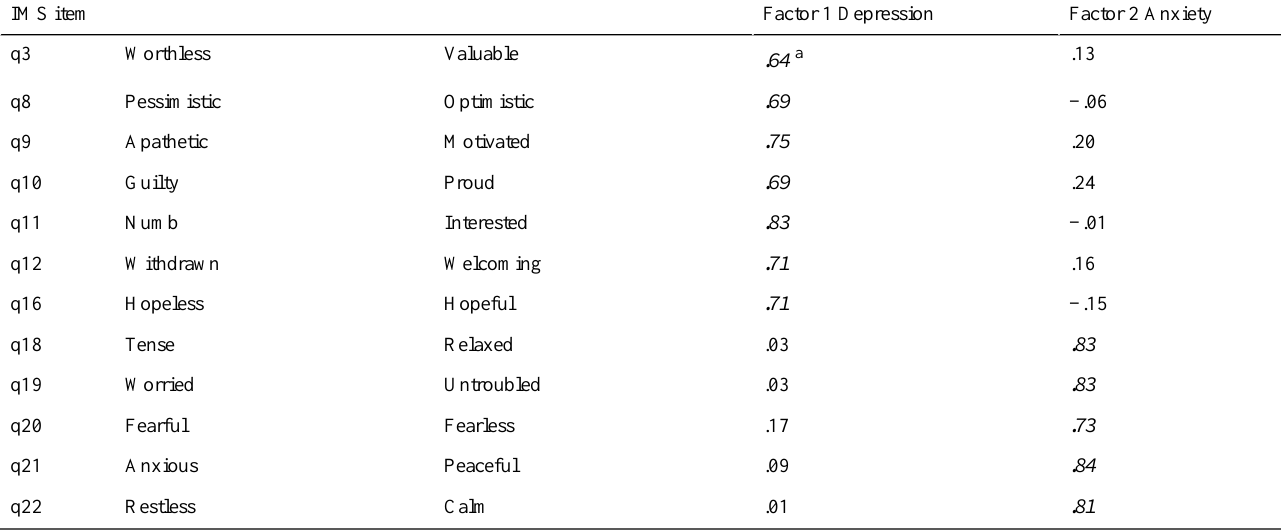
Table 1. Factor analysis pattern matrix for IMS-12 items.